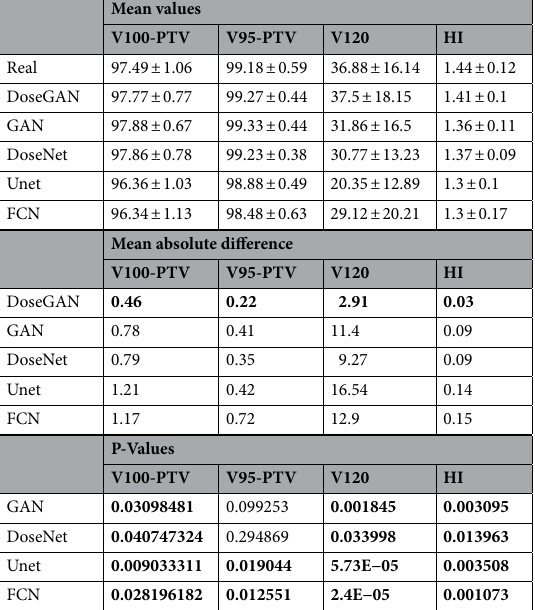
Table 1. The mean values, mean absolute differences between the real dose and each algorithm, and the comparator p-values between DoseGAN and each alternative algorithm are shown for the V 95 , V 100 , and V 120 of the PTV as well as the HI. Bold font indicates the least difference between the real and predicted dose and statistically significant